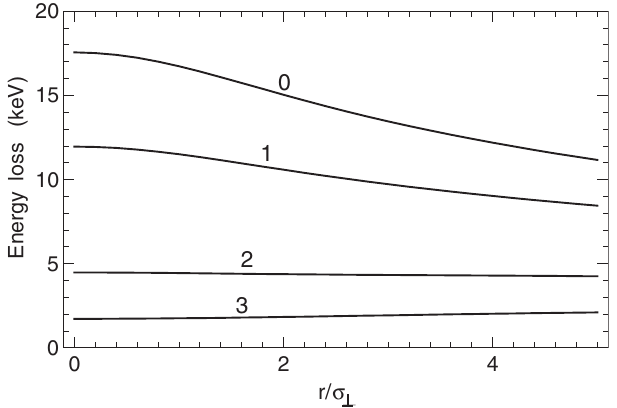
FIG. 3. Energy loss induced by the acceleration field for four different slices in the bunch ( z=(cid:4) is indicated near the curves) as a function of electron radial